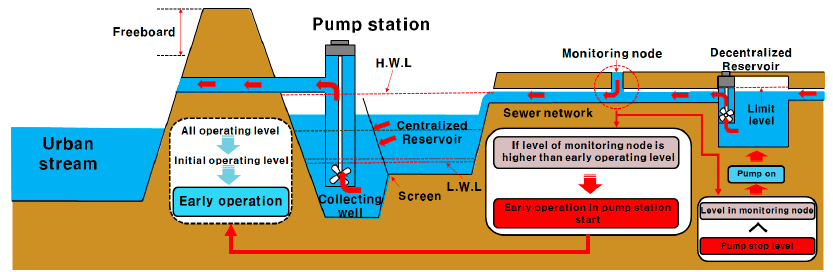
Figure 7. Cooperative operation of a centralized and a decentralized reservoir.